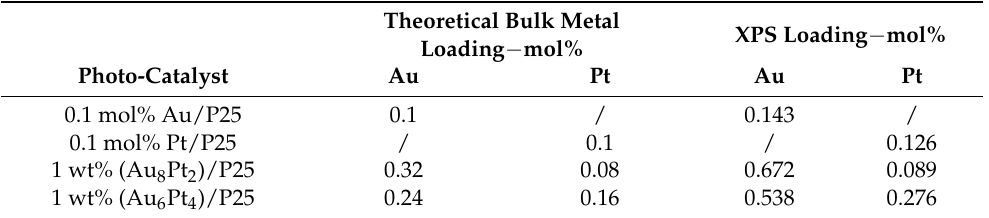
Table 3. Theoretical composition vs. abundance calculated through XPS of selected